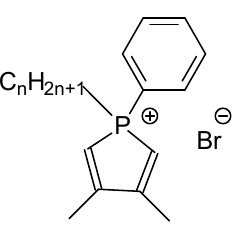
Scheme 1. Molecular structure of alkyldimethylphenylphospholium surfactants 14pl (n = 14), 15pl (n = 15), 16pl (n = 16), 17pl (n = 17), 18pl (n = 18).